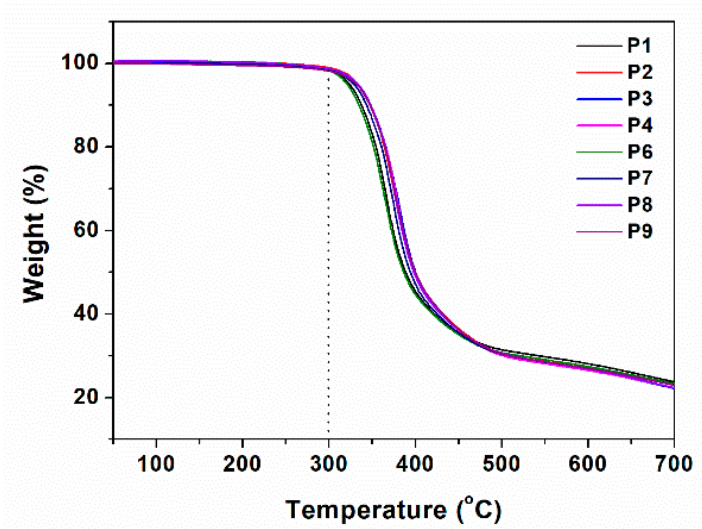
Figure 9. Thermogravimetric analysis (TGA) thermograms (under nitrogen, at 10 °C·min − 1 ) of the copolymers.